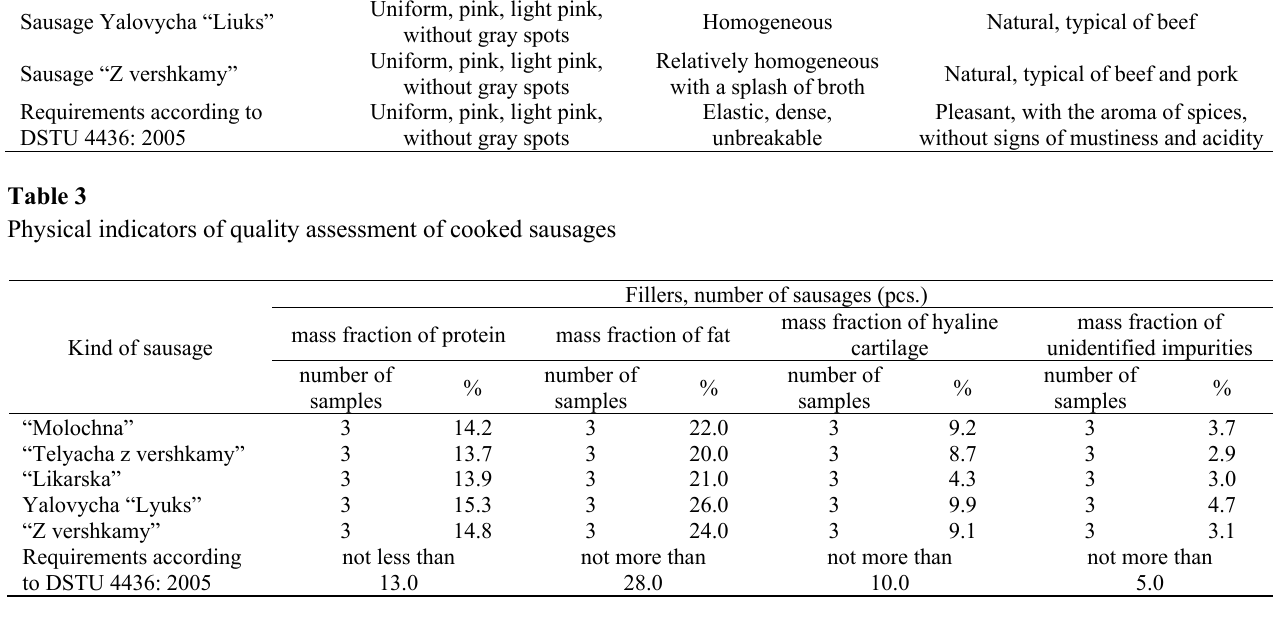
Organoleptic characteristics of the studied samples of sausages Name of cooked sausages